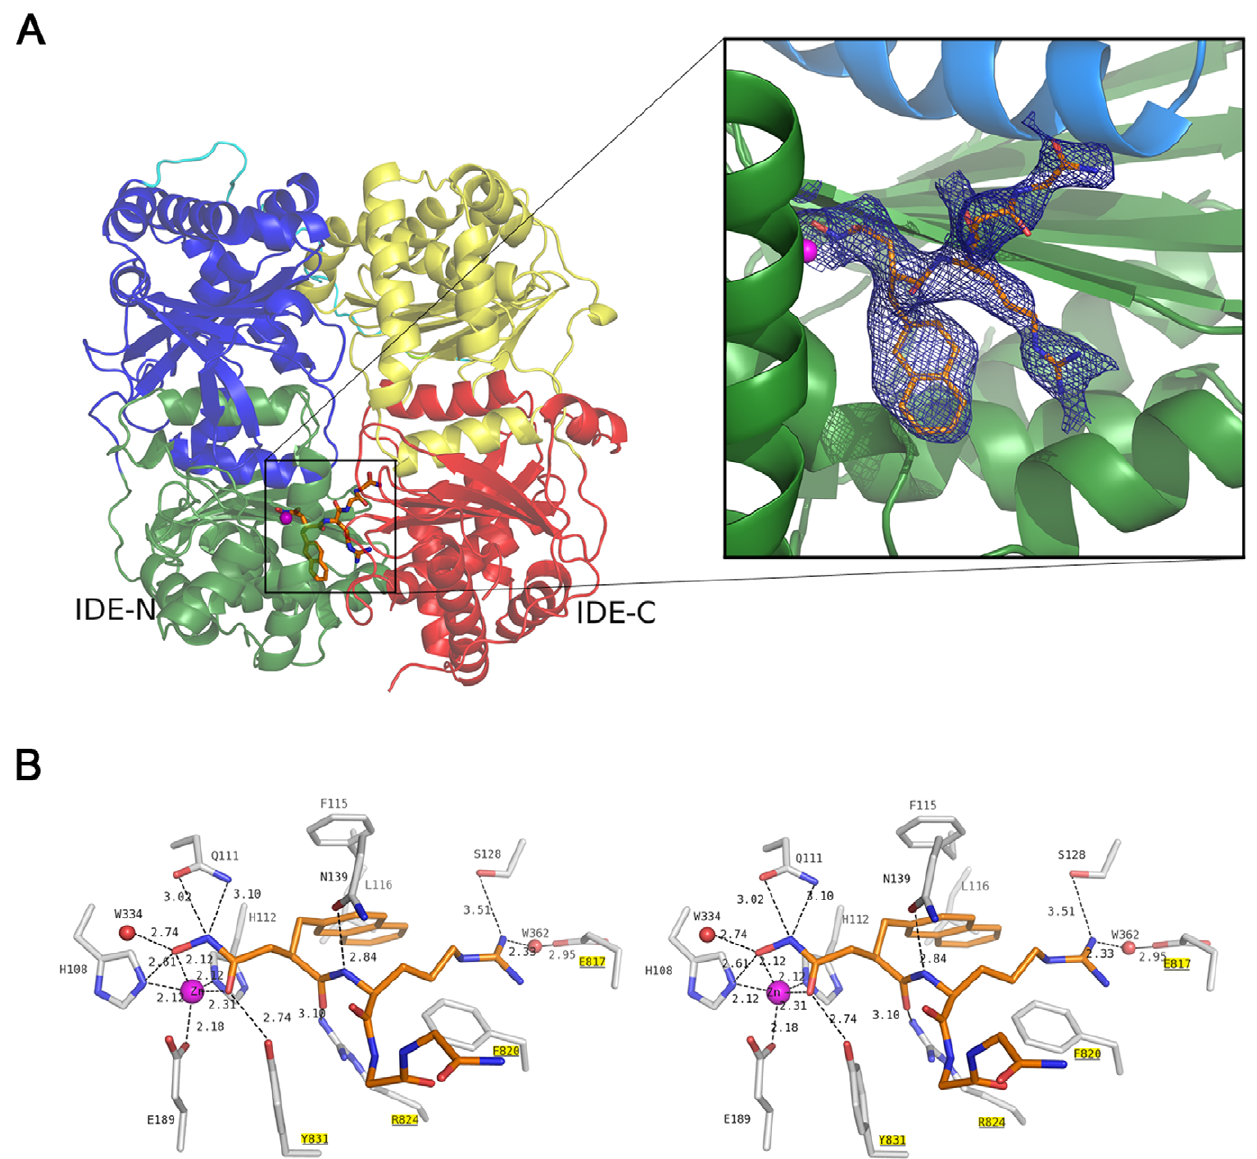
Figure 4. Structure of human IDE complexed to inhibitor Ii1. A , Overall structure of Ii1-bound IDE. Ribbon diagram of monomeric IDE colored as green , blue , yellow and red for domains 1, 2, 3 and 4, respectively ( left ). The connecting loop between IDE-N and IDE-C is shown in cyan . 2 F o –F c simulated annealing omit map contoured at 1 s is shown in blue around Ii1 ( right ). In this view, the C-terminal domains of IDE ( yellow , red ) have been omitted to highlight the interactions of Ii1 with the catalytic zinc atom in the N-terminal domain of IDE. B , Stereodiagram showing the detailed interactions of Ii1 with residues and zinc ion in the catalytic site of IDE. Protein residues involved in catalysis and in contact with Ii1, as well as the inhibitor are drawn in stick representation . Residues from the C-terminal half of IDE are underlined and highlighted in yellow . Ii1 in stick representation is colored the same as in ( A ). Carbon nitrogen and oxygen atoms of Ii1 are colored orange and those of IDE grey ; nitrogen and oxygen atoms are colored blue and red , respectively; zinc and water are represented by spheres colored magenta and red , respectively. Hydrogen bonds are shown as dashed lines . Figures generated using Pymol [50].